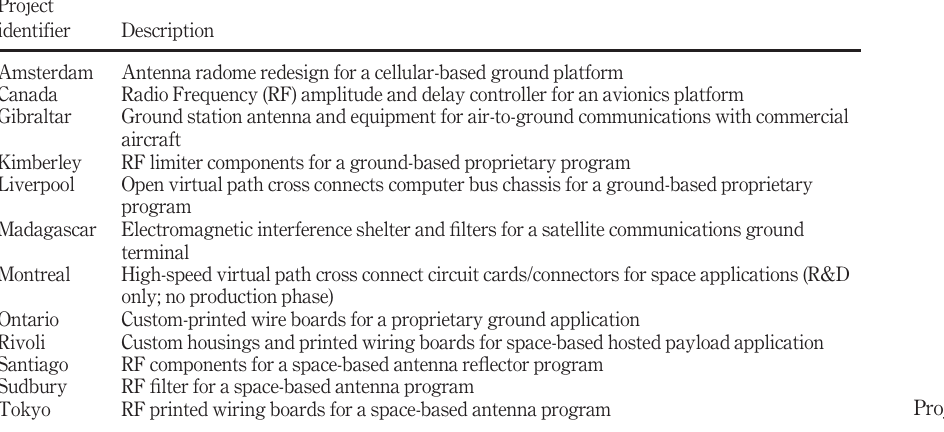
Table II. Project